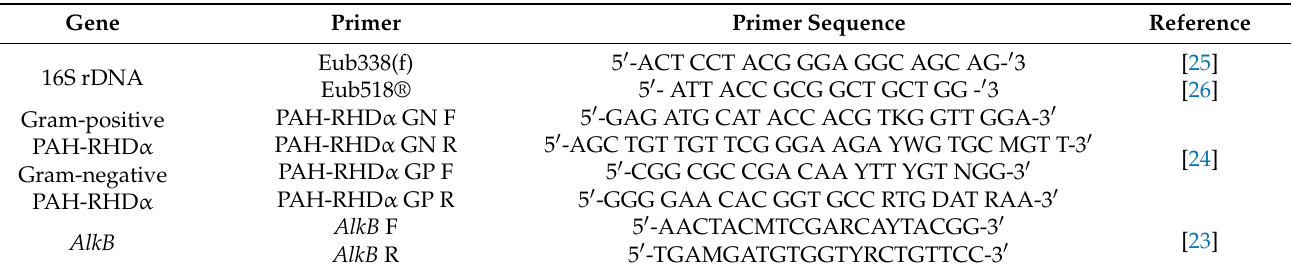
Table 3. Primers used in the qPCR